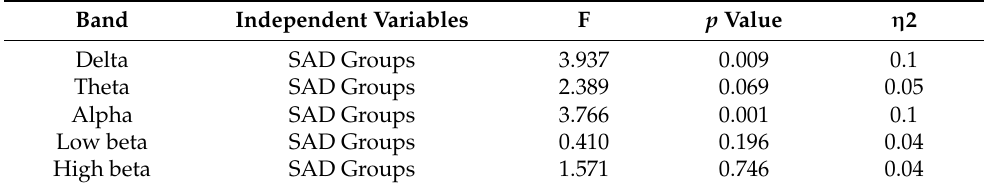
Figure 3. Average values of effective connectivity (EC) across different frequency bands in all SAD patients and healthy controls (HCs). Table 3. ANOVA comparisons between partial directed coherence (PDC) values and social anxiety disorder (SAD)